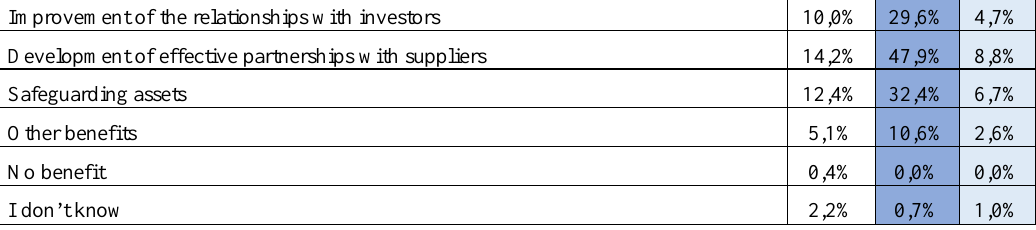
HOW DO YOU ASSESS THE OVERALL RELATIONSHIP BETWEEN COSTS AND BENEFITS RELATED TO INITIATIVES CARRIED OUT Benefits are lower than costs Benefits and costs are matched Benefits are greater than costs